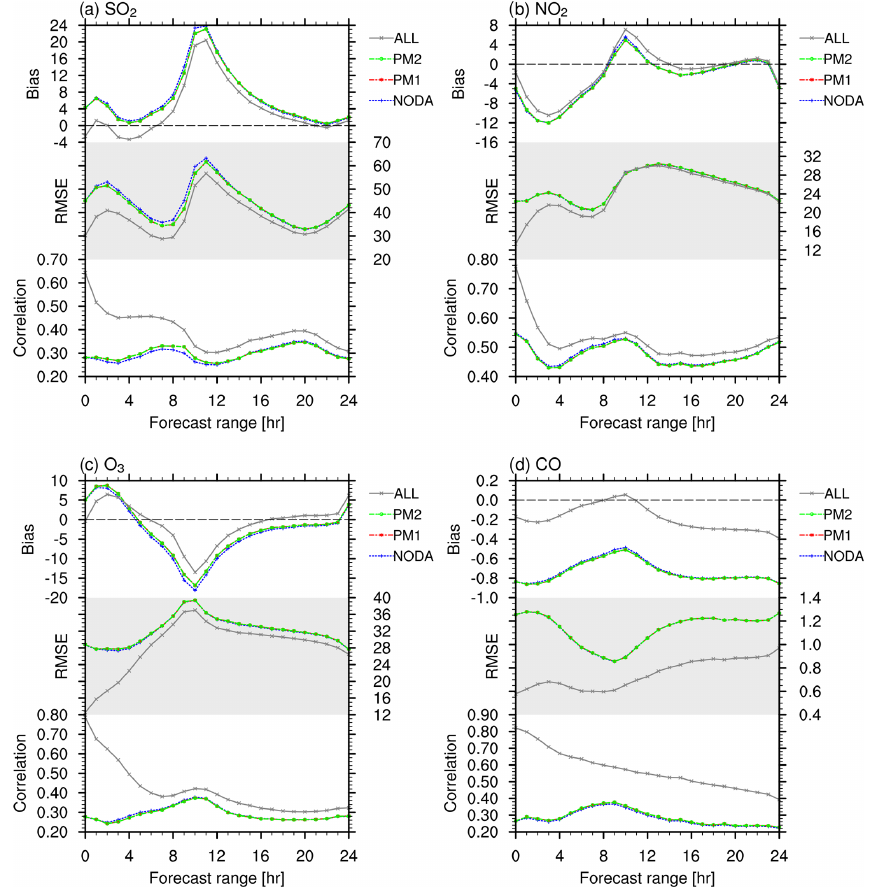
Figure 7. Same as Fig. 6, but for the forecast of (a) SO 2 , (b) NO 2 , (c) O 3 (units: µgm − 3 ), and (d) CO (units: mgm − 3